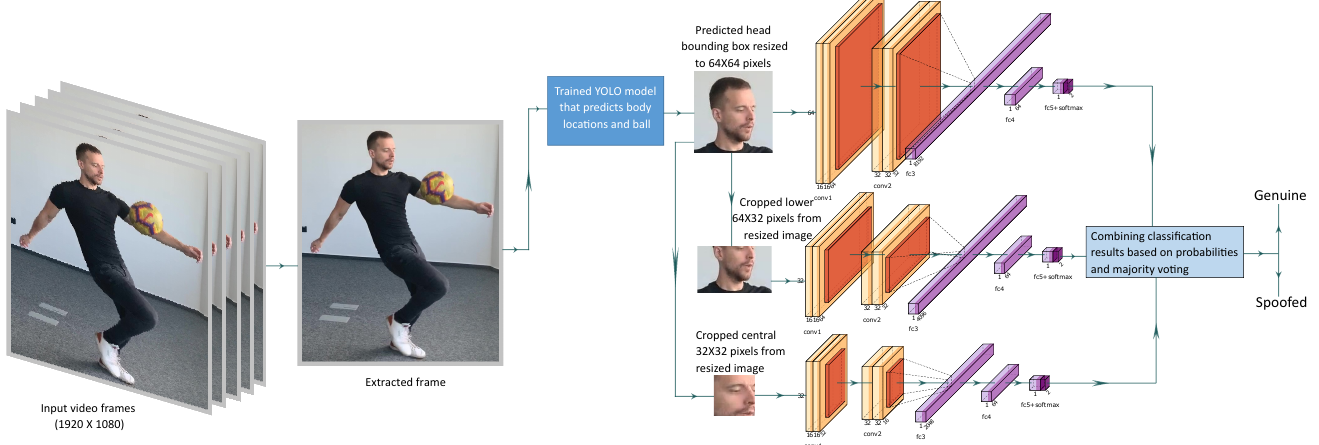
Figure 6. Our ensemble multi-stream model: frames are extracted from videos and one frame is processed at a time in three different streams. The outputs of the three streams are combined to derive the final classification